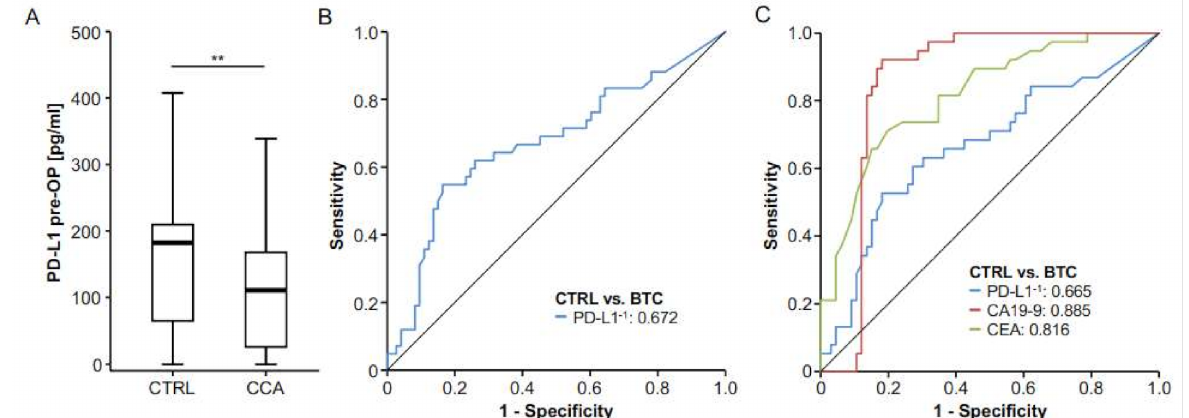
Figure 1. Serum levels of circulating PD-L1 are decreased in patients with BTC. ( A ) Serum levels of circulating PD-L1 are significantly lower in patients with BTC compared to healthy controls. ( B ) ROC curve analysis reveals an AUC value of 0.672 for circulating PD-L1 when measured for the differentiation between BTC and healthy controls. ( C ) Routinely measured BTC tumor markers showed higher AUC values for this setting (CEA: 0.816, CA19-9: 0.885); ** p <